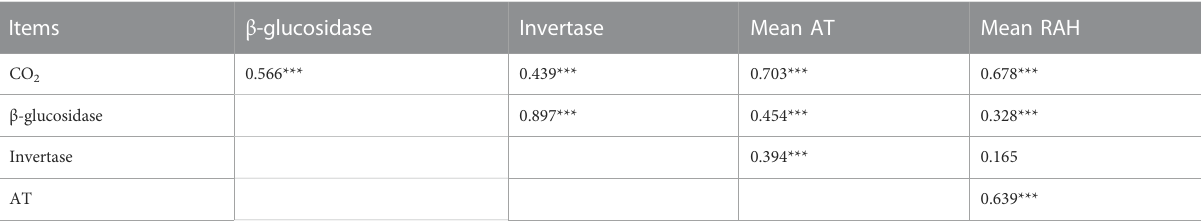
TABLE 2 Relationship between cumulative CO 2 emissions, enzyme activities, and environmental factors on the seasonal scale (n = 96). Items β -glucosidase Invertase Mean